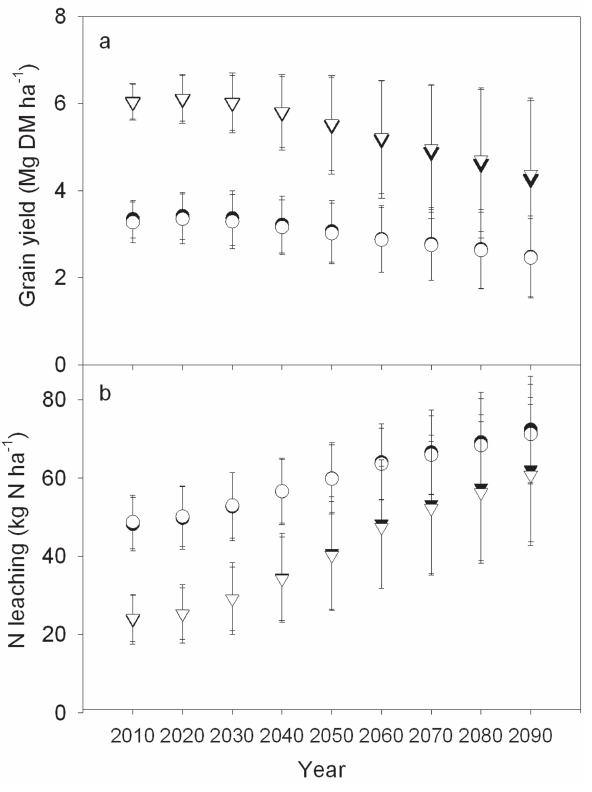
Fig. 5. Probability of yield reductions in individual years larger than 20% compared to mean yield simulated for baseline and prob- ability of N leaching in individual years exceeding threshold levels of 50kgNha − 1 for loamy sand and 70kgNha − 1 for sandy soils. Results were calculated for projected climate conditions at 10-yr in- tervals during the 21st century for the A1B emission scenario using the two methodologies A and